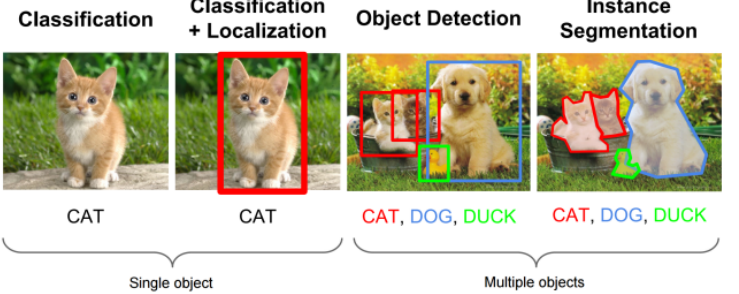
Figure 17. Image classification, localization, detection, and segmentation as downstream tasks in computer